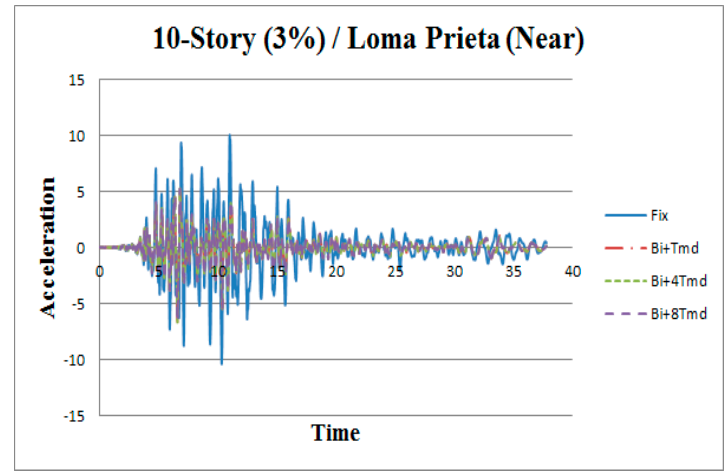
Figure 6. Acceleration time histories for top story of 10-story building under the Loma Prieta (near-fault) earthquake.